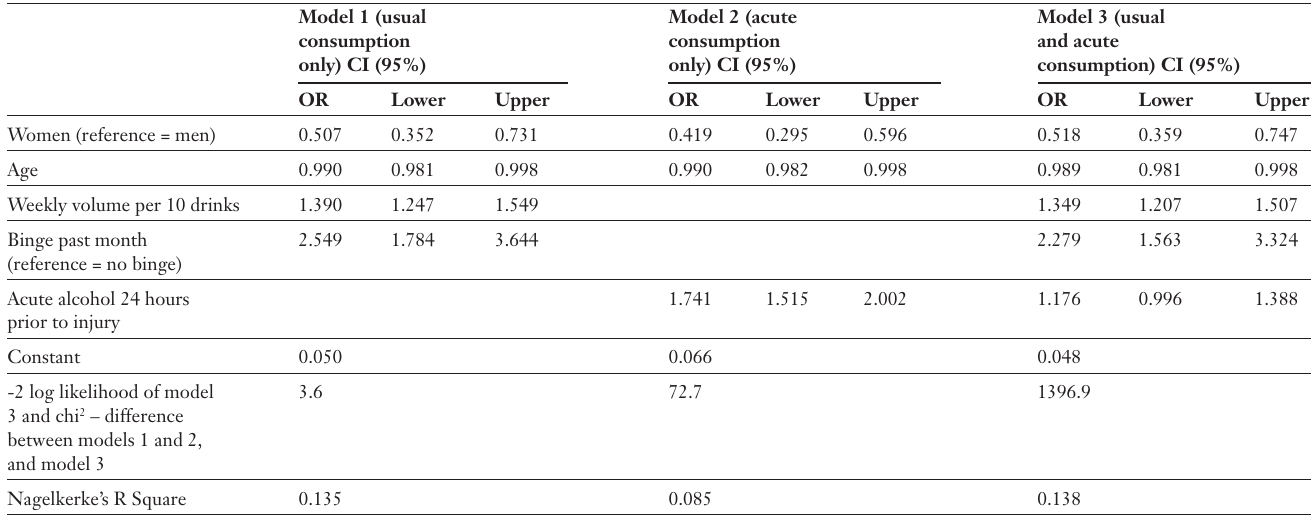
Logistic regressions of prior alcohol-related injury on usual and acute alcohol consumption among current injury patients only. Model 1 (usual Model 2 (acute Model 3 (usual consumption consumption and acute only) CI (95%) only) CI